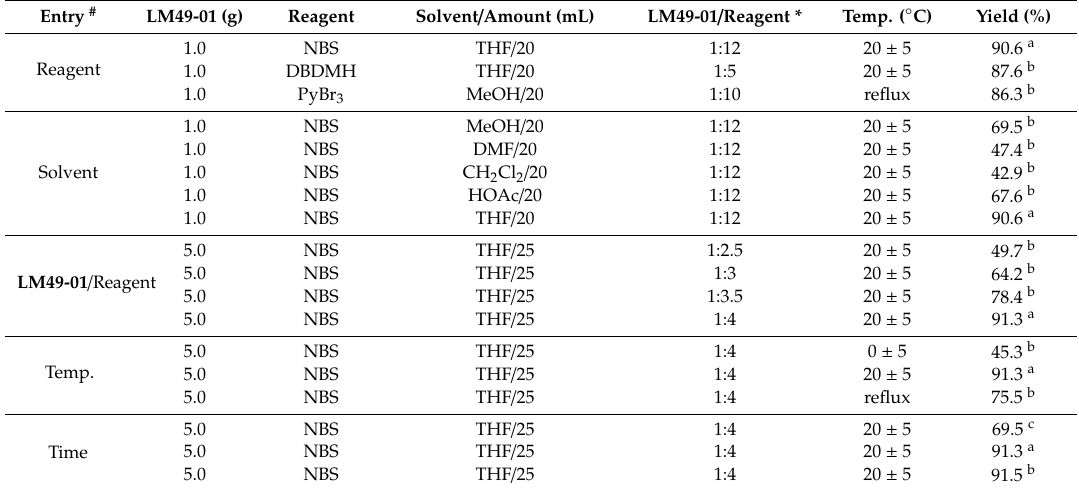
Table 3. Parameter optimization of synthetic process of LM49-02